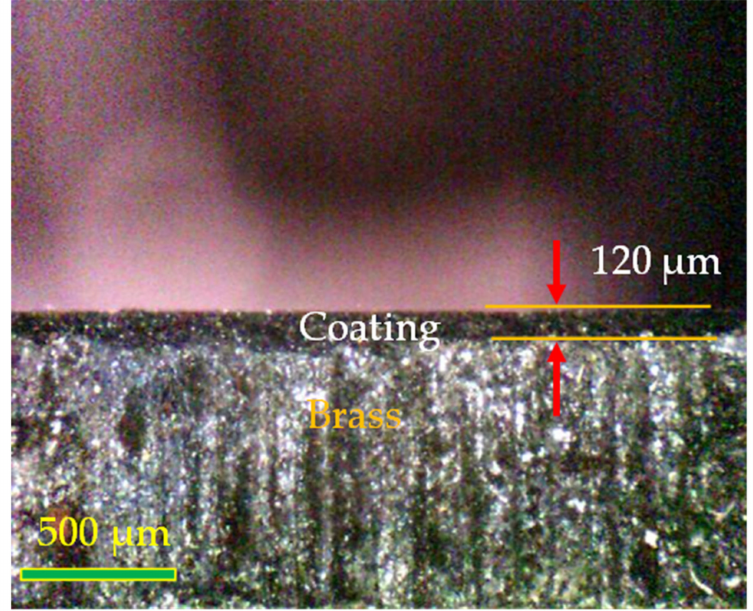
Figure 4. Optical image showing the thickness of the hydrothermally carbonized